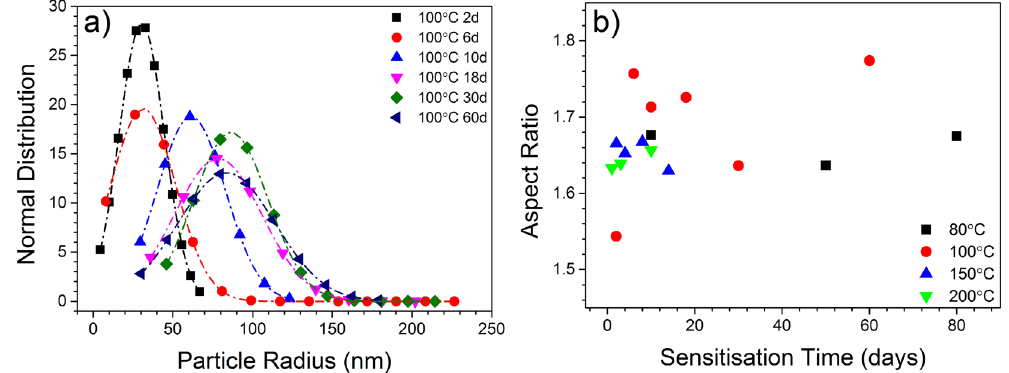
Figure 9. ( a ) The normal distribution of grain boundary β -phase particle radius in AA5083 which sensitised at 100 °C for 2 to 60 days, ( b ) the average aspect ratio of β -phase particles observed on Ga-embrittled fracture surface of alloys with different sensitisation heat